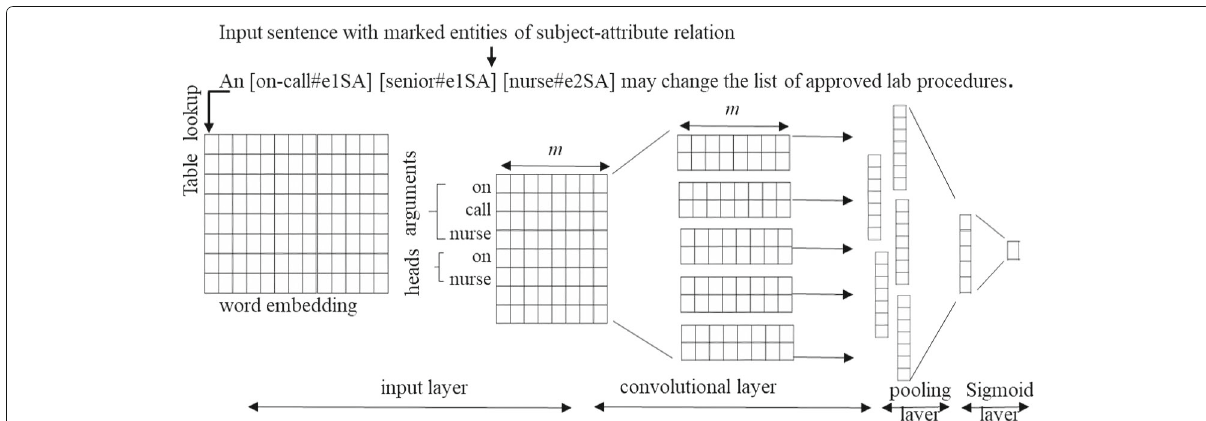
Fig. 6 The architecture of the CNN model. The marked (or annotated) arguments of a subject-attribute instance are obtained as discussed in “Identify patterns encoding the target relations” section. The arguments and their heads are concatenated and fed to the network using word embeddings